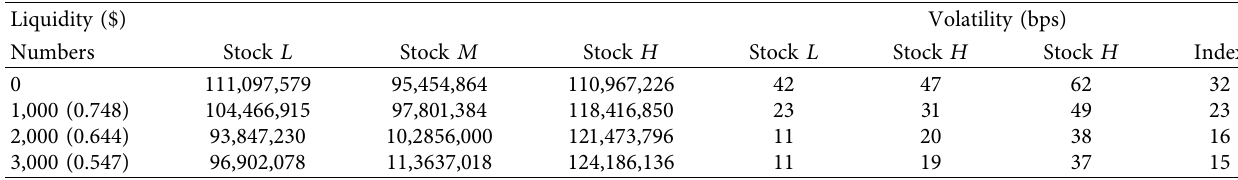
Table 15: Impact of hedgers on spot market liquidity and